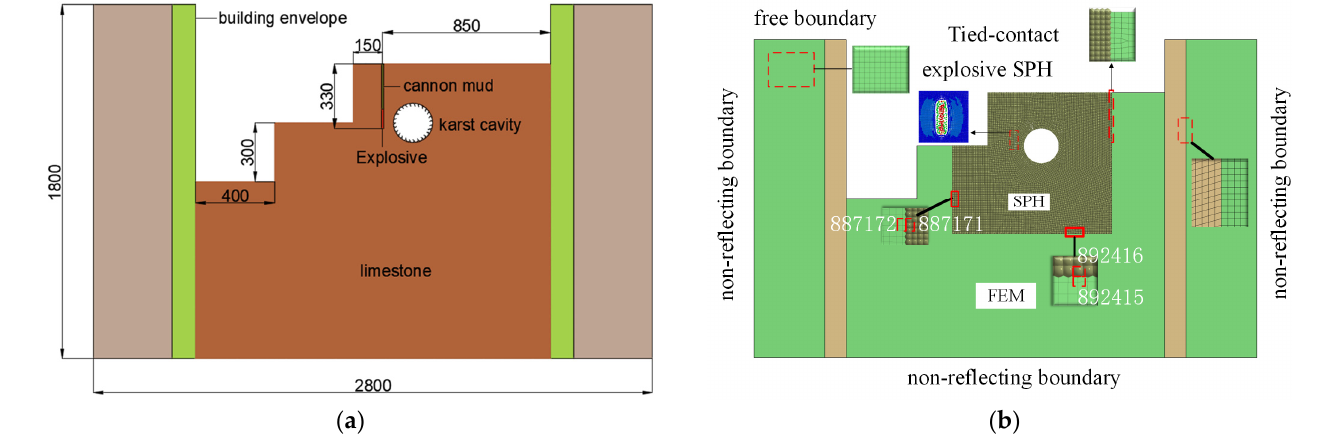
Figure 7. Model introduction. ( a ) Geometric model (unit: cm); ( b ) SPH-FEM